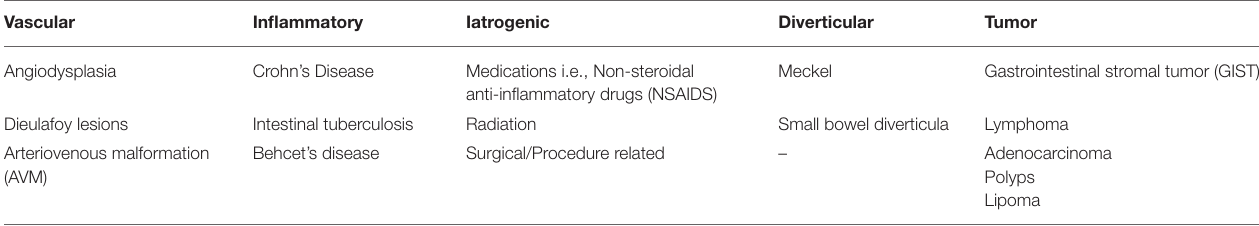
TABLE 1 | Common causes of small bowel bleeding.